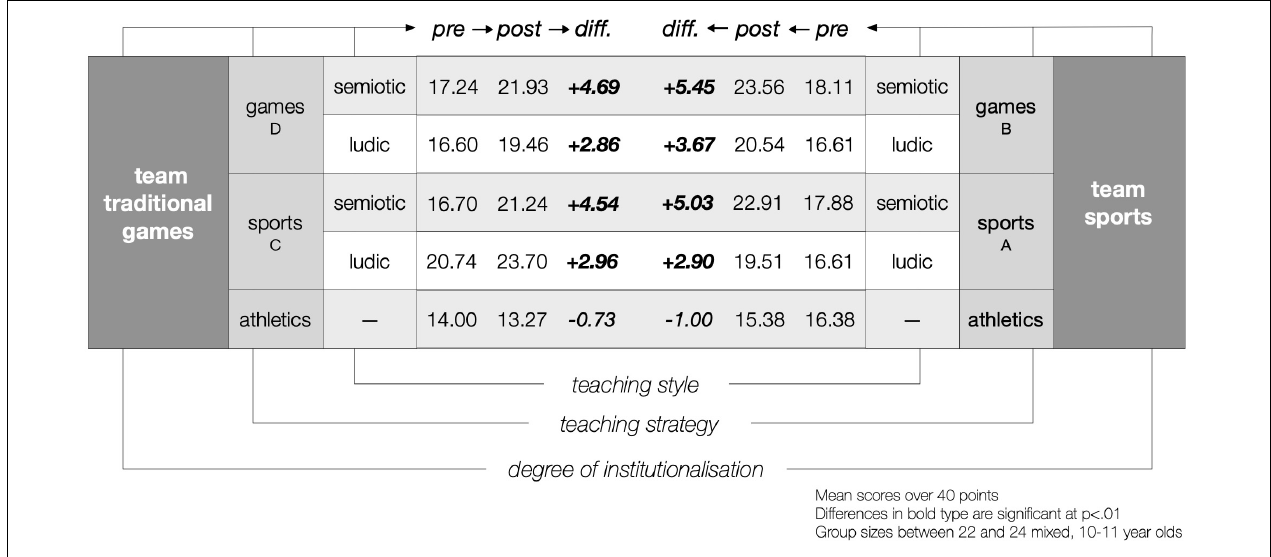
FIGURE 3 | Learning transfer, traditional games, and sports (Dugas,